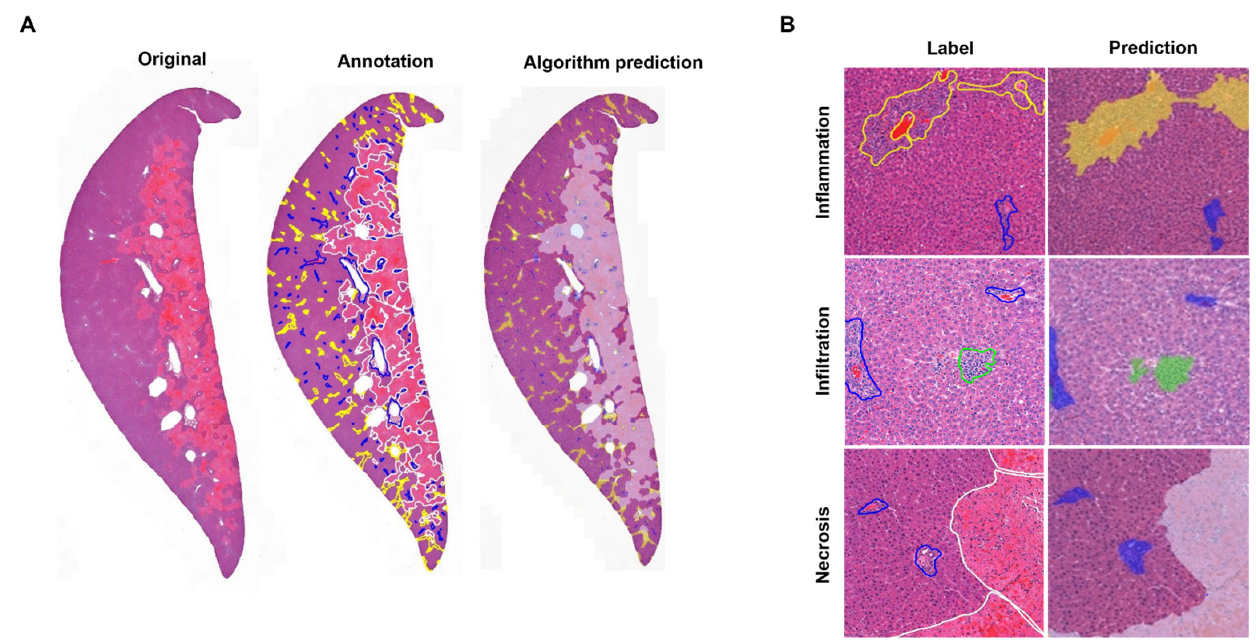
Figure 3. Comparison of the original image, annotated image, and algorithm-predicted image at the WSI level. ( A ) Original WSI, annotated result obtained from an accredited toxicologic pathologist,